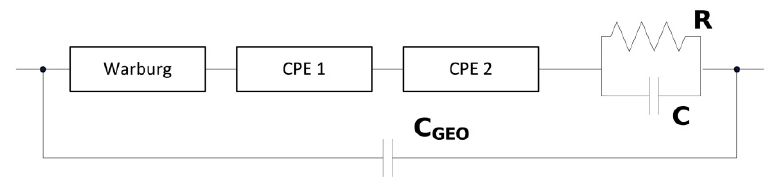
Figure 12. Electrical response equivalent circuit model.